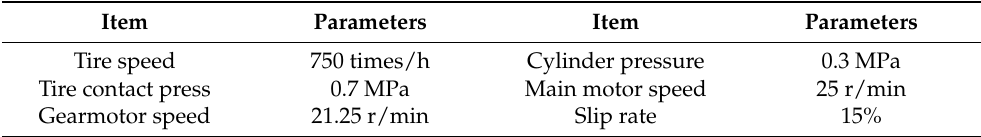
Table 5. The setting parameters for